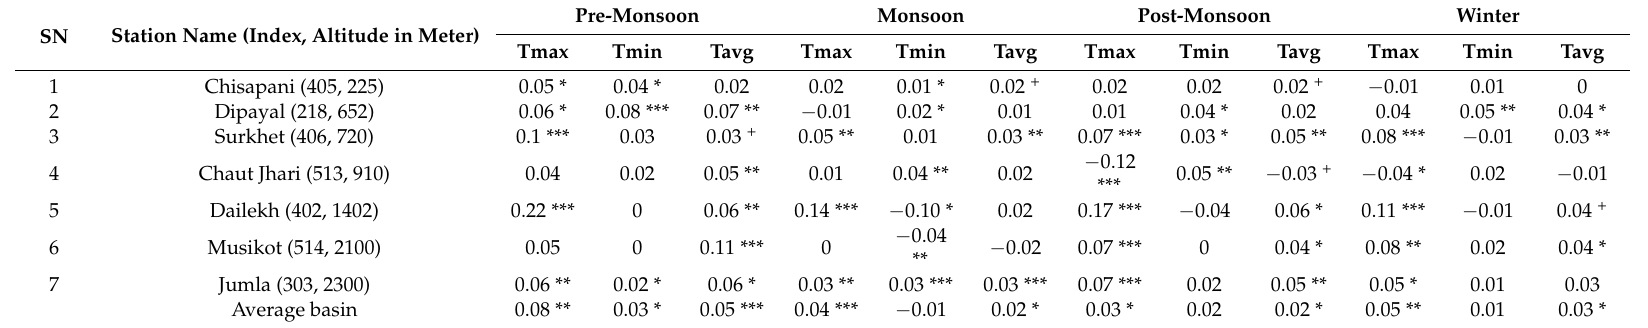
Table 2. Temperature trend ( ◦ C/year) in different elevations of the KRB.